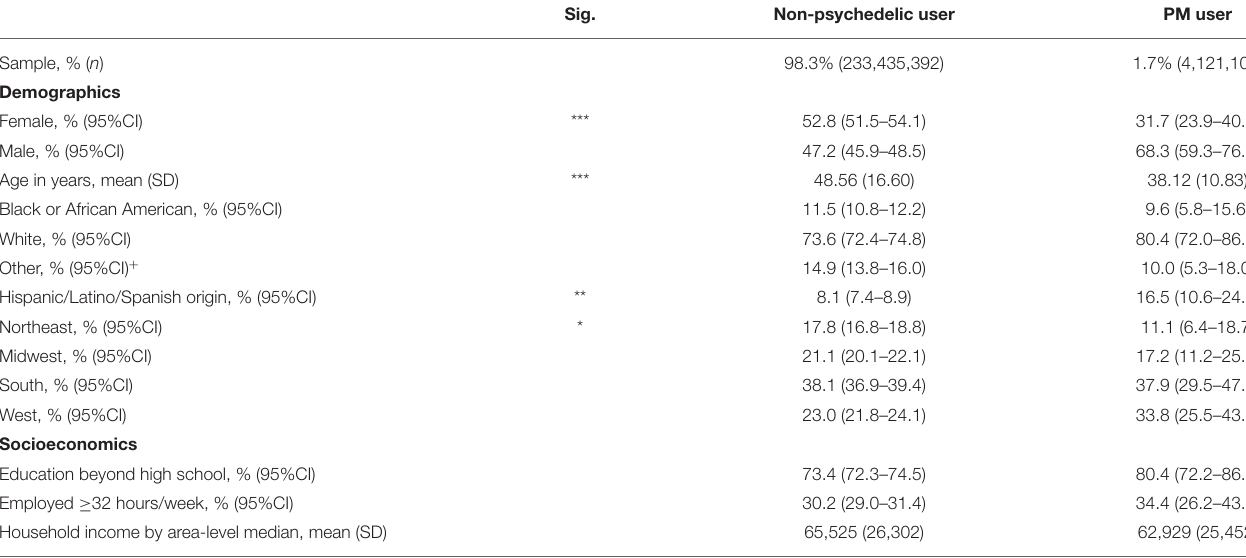
TABLE 1 | Descriptive non-psychedelic user and PM user characteristics, US Adult population 2020/21 (weighted).